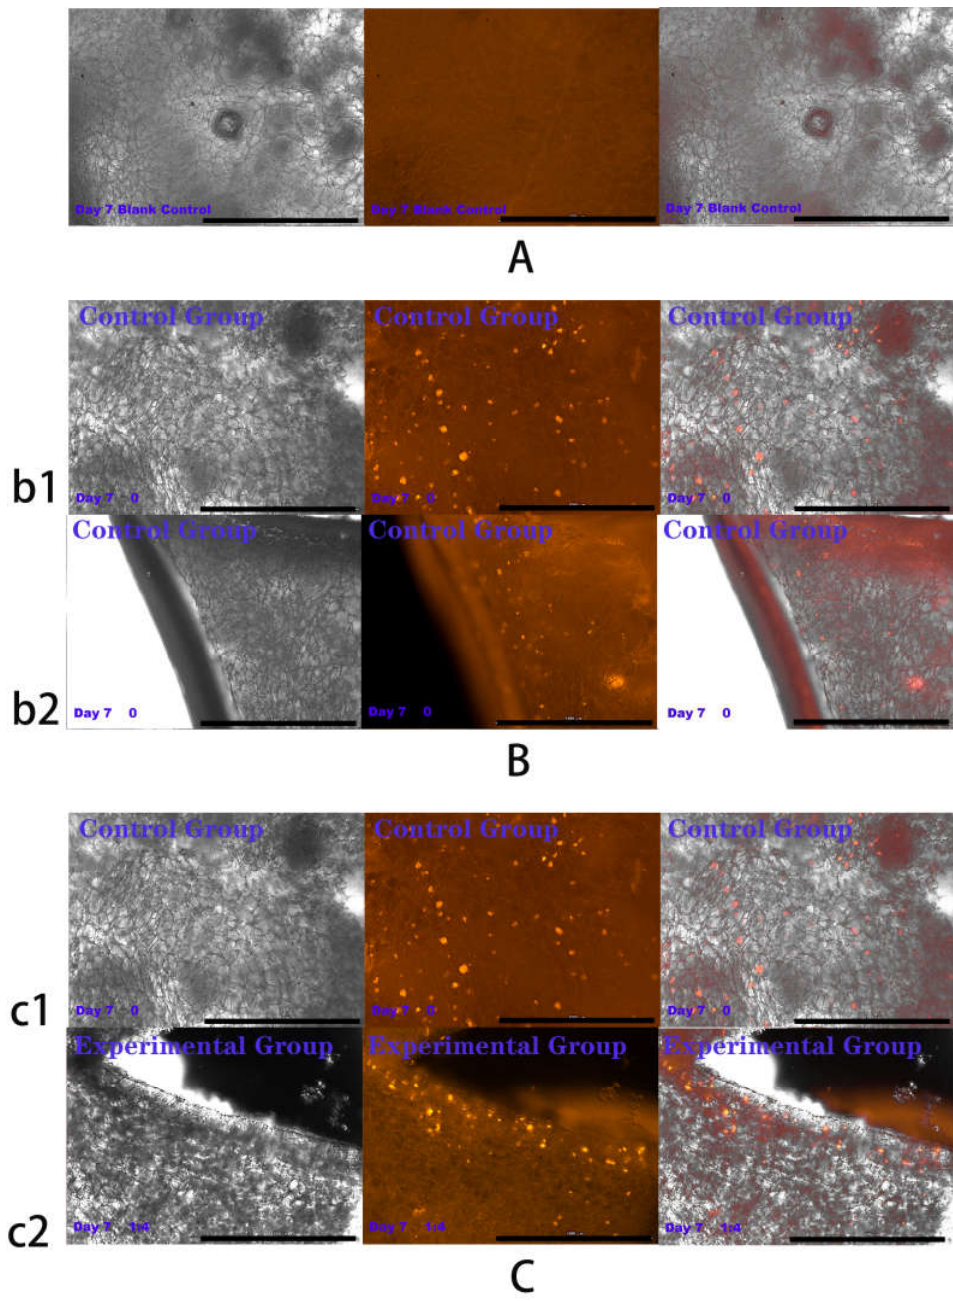
Figure 15. Cells were co-cultured for 7 days. Growth of HSFs labeled with amino graphene quantum dots on tissue engineering scaffolds. b1 and c1 and are fluorescence maps of HSFs growing on the surface of tissue engineering scaffolds. b2 and c2 are fluorescence maps of HSFs growing on the cross section of the tissue engineering scaffolds. ( A ) Blank group, ( B ) control group, ( C ) is experimental group. From left to right are the bright field diagram, the fluorescent field diagram, and the sum diagram of the bright field and the fluorescent field. Scale bar: 1000 μm.